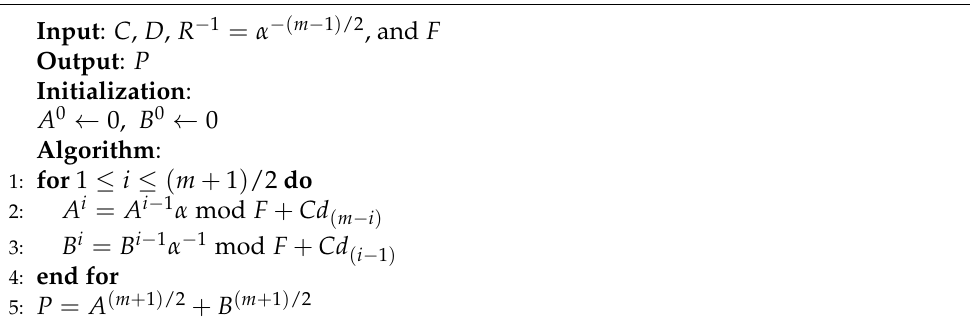
Algorithm 1 Montgomery Multiplication Algorithm in GF(2 m